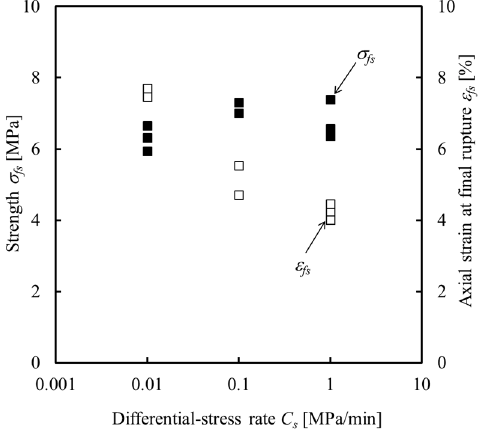
Figure 5. Strength σ fs and axial strain at the final rupture ε fs versus differential-stress rate C s in constant-stress-rate tests [22].